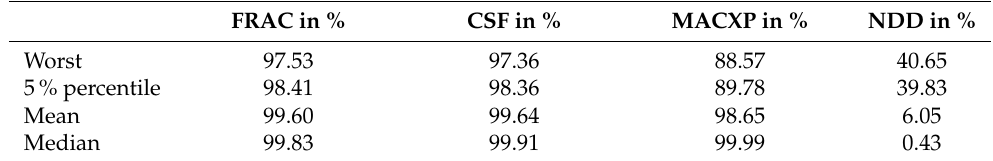
Table 5. Statistics of model performance indicators using the identified stiffness and damping parameters for the case “model vs. disturbed model” for the validation position z 1